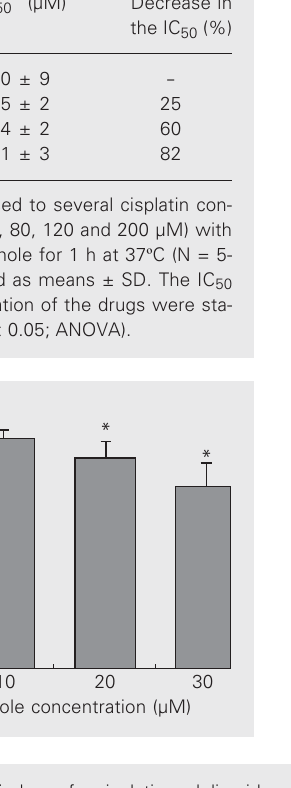
Table 1. Effect of dipyridamole on the cytotoxicity of cisplatin in the human larynx HEp-2 cell line. Dipyridamole IC 50 (µM) Decrease in (µM) the IC 50 (%)